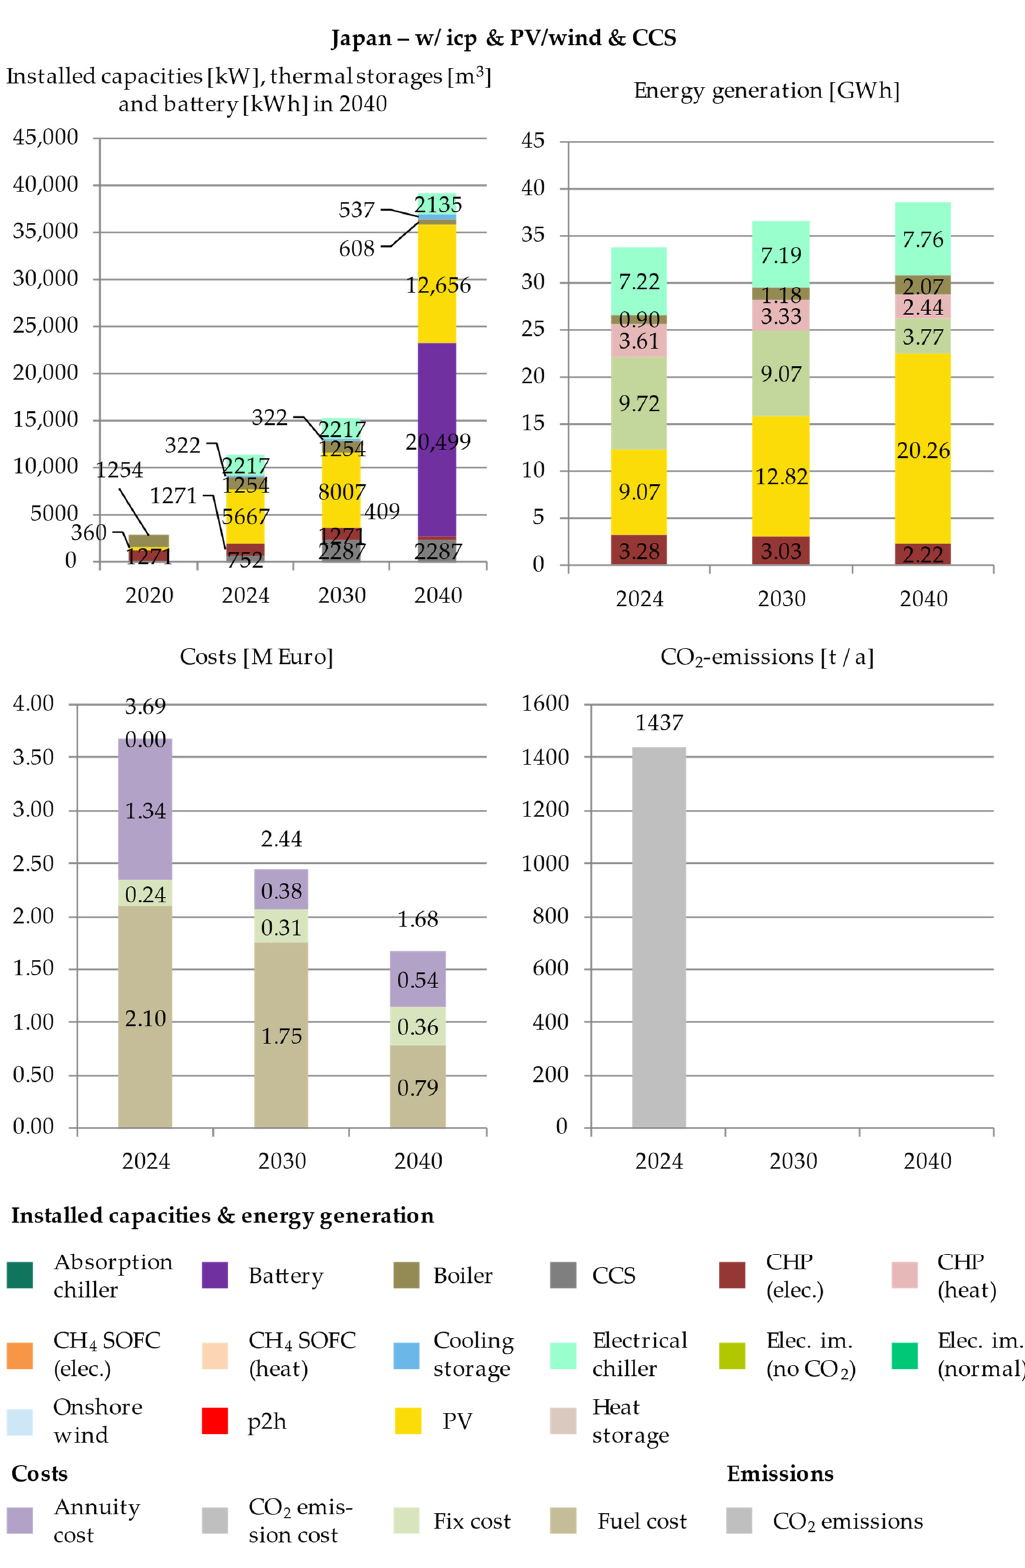
Figure A10. Detailed results for the Japanese “w/ICP and PV/wind and CCS” scenario.